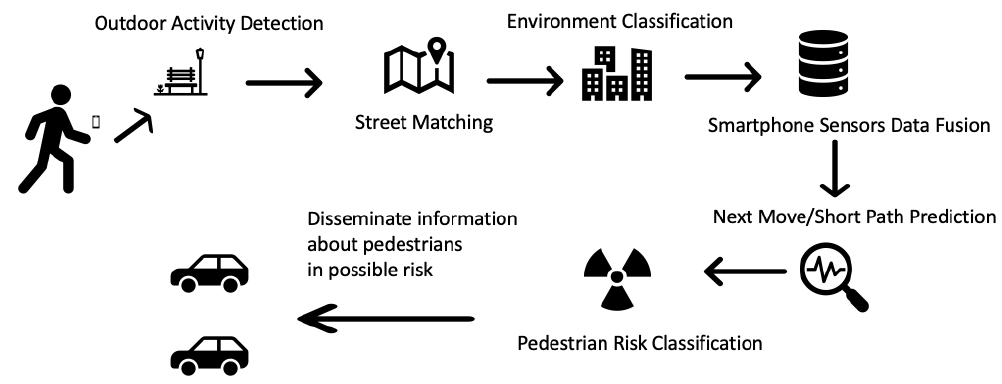
Figure 15. Proposed P2V